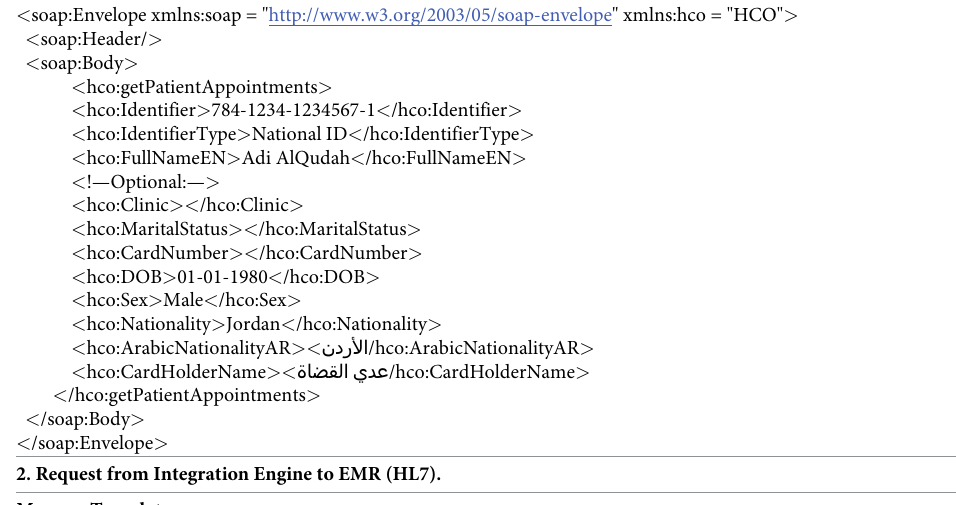
Table 1. First step to request patient and appointment details for verification. 1. Request from QMS to Integration Engine